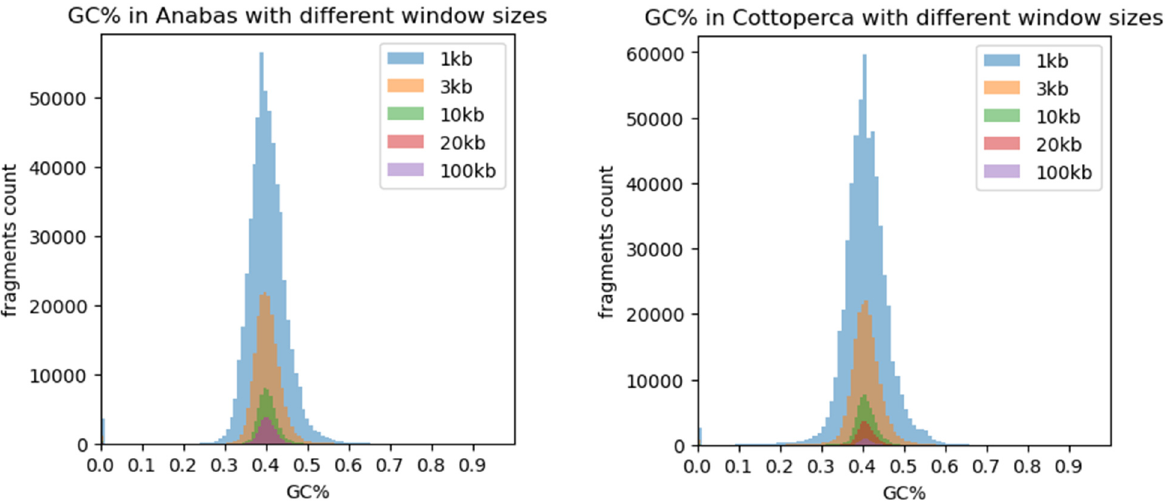
Figure 5. Distribution of GC% values resulting from the usage of five different sliding window sizes. Histograms for the two species, A. testudineus ( left ) and C. gobio ( right ), show a comparable reduction in the range of GC% values with increasing sliding window size. Note: For the histogram of GC% with the 100 kb sliding window size, which is routinely used in assessing the GC content of genomes, the bars are too small to be viewed at the scale of the image.